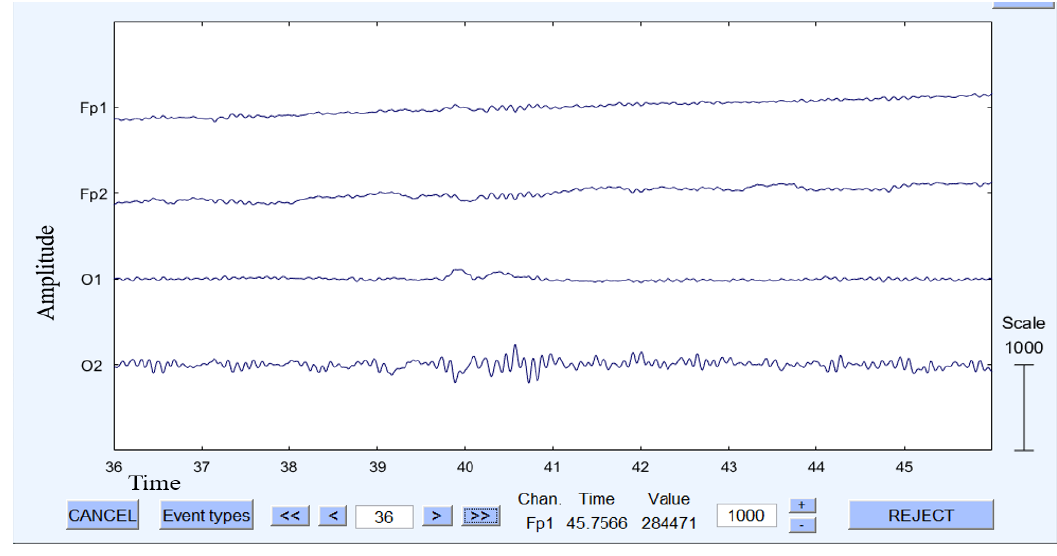
Fig. 8. The frontal and occipital channels with filtering.